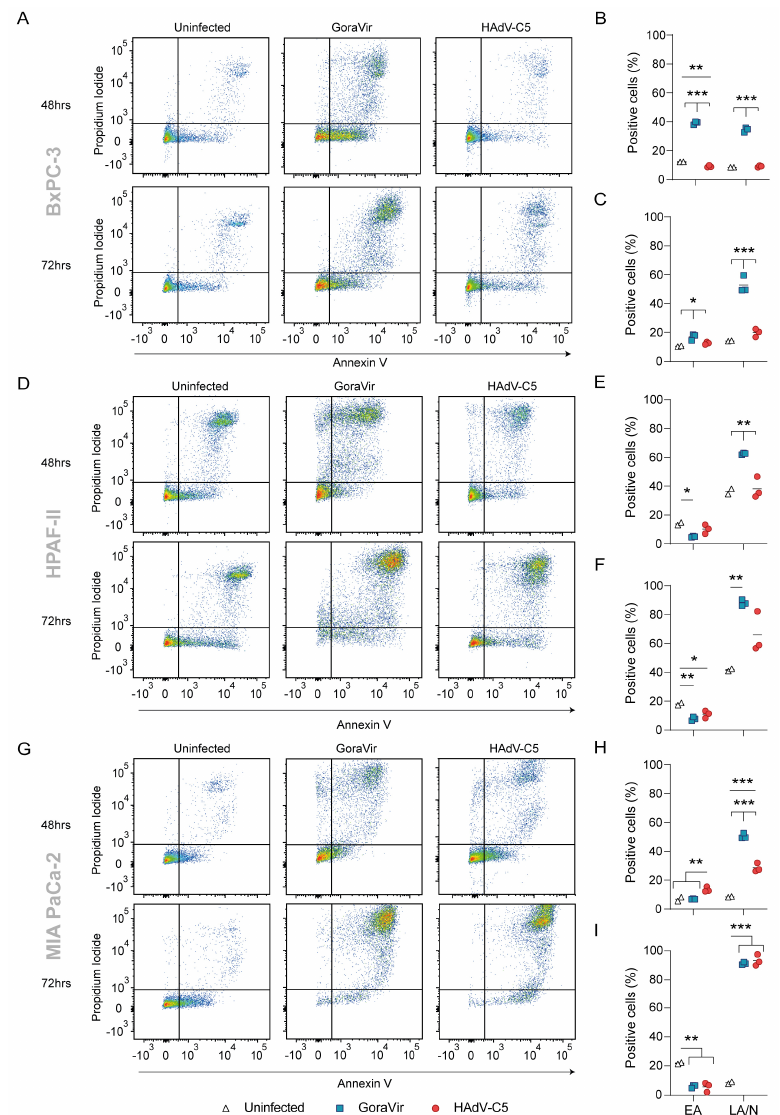
Figure 1. Virus-induced cell death of pancreatic cancer cell lines by GoraVir. Cells were infected with GoraVir or HAdV-C5 at MOI 10 and stained with Annexin V and propidium iodide at 48 and 72 hrs post infection (hpi). Depicted are representative figures out of n = 3 for ( A ) BxPC-3, ( D ) HPAF-II, and ( G ) MIA PaCa-2. Annexin V + PI- cells were classified as early apoptotic (EA) cells and Annexin V-PI+ and Annexin V + PI+ together as late apoptotic/necrotic (LA/N) cells. Percentage of single cell population in EA or LA/N was determined at 48 and 72 hpi for BxPC-3 ( B , C ), HPAF-II ( E , F ), and MIA PaCa-2 ( H , I ), respectively. Depicted are means of n = 3 and comparisons were performed using one-way ANOVA with Tukey correction for multiple testing. Significant differences are indicated by asterisks, with p values < 0.05 shown as *, <0.01 as **, and <0.001 as